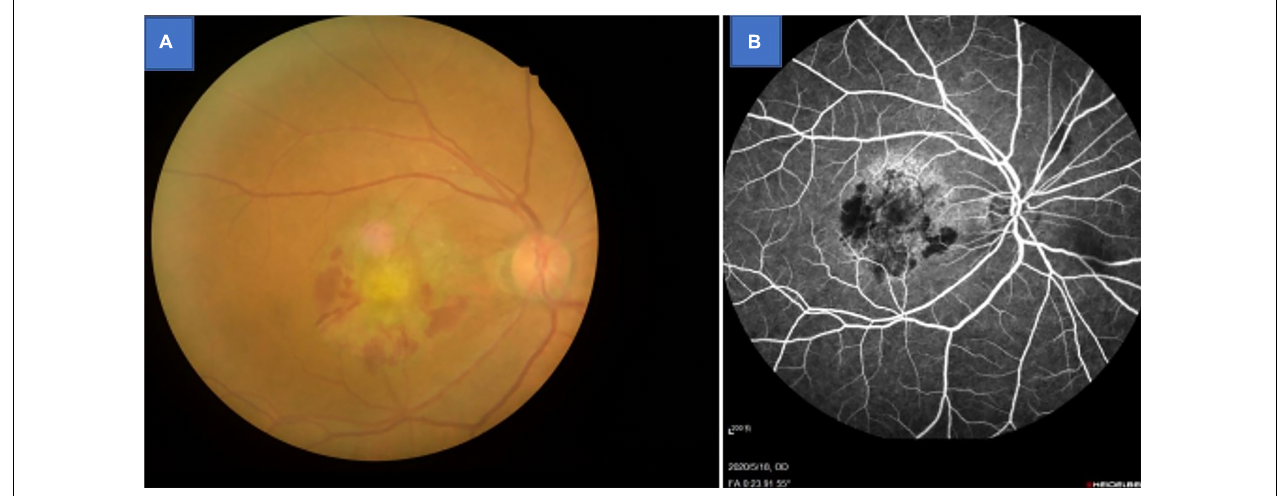
FIGURE 1 | Example of age-related macular degeneration seen on fundus camera (A) and fluorescence fundus angiography (B)